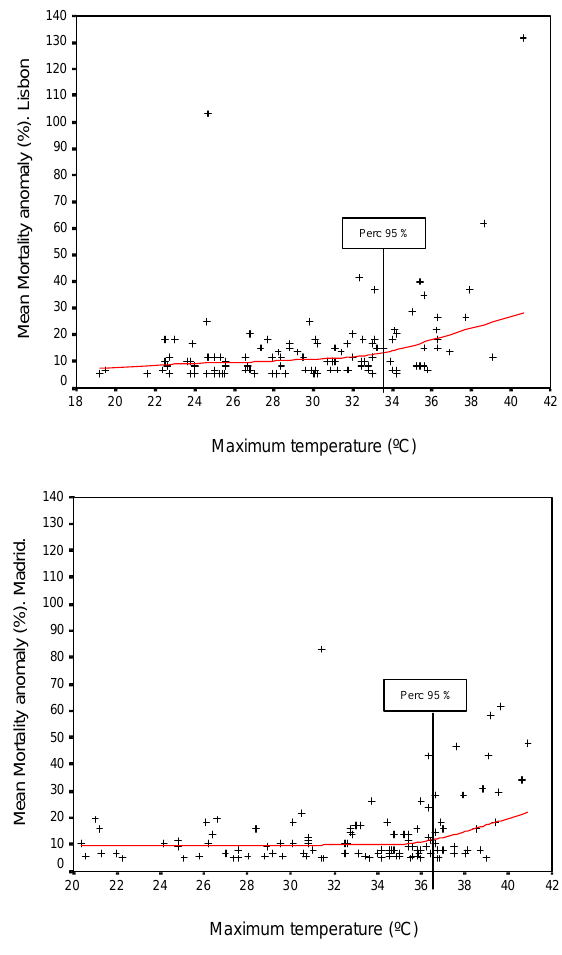
Fig. 1. ( a ) Daily mortality anomalies (anomalies > 0) versus daily maximum temperatures for Lisbon. The solid line corresponds to a minsce method with 50% of the points and 3 iterations adjust- ment. The corresponding 95 percentile T max value for Lisbon is also represented. ( b ) Daily mortality anomalies versus daily max- imum temperatures for Madrid. The solid line corresponds to a minsce method with 50% of the points and 3 iterations adjustment. The corresponding 95 percentile T max value for Madrid is also rep- resented.